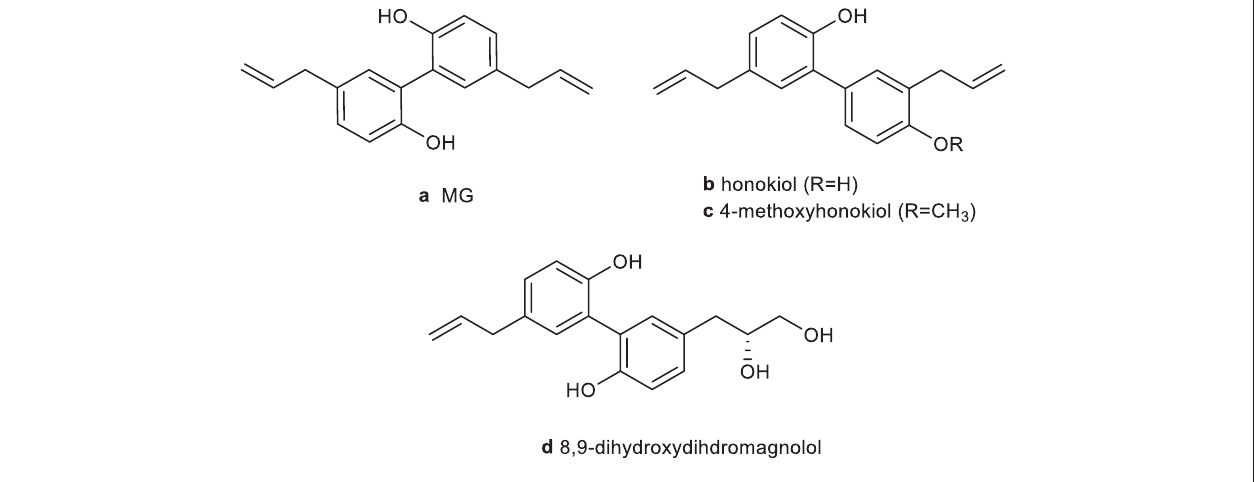
FIGURE 1 | Chemical structure of the main neolignans of Magnoliae of fi cinalis